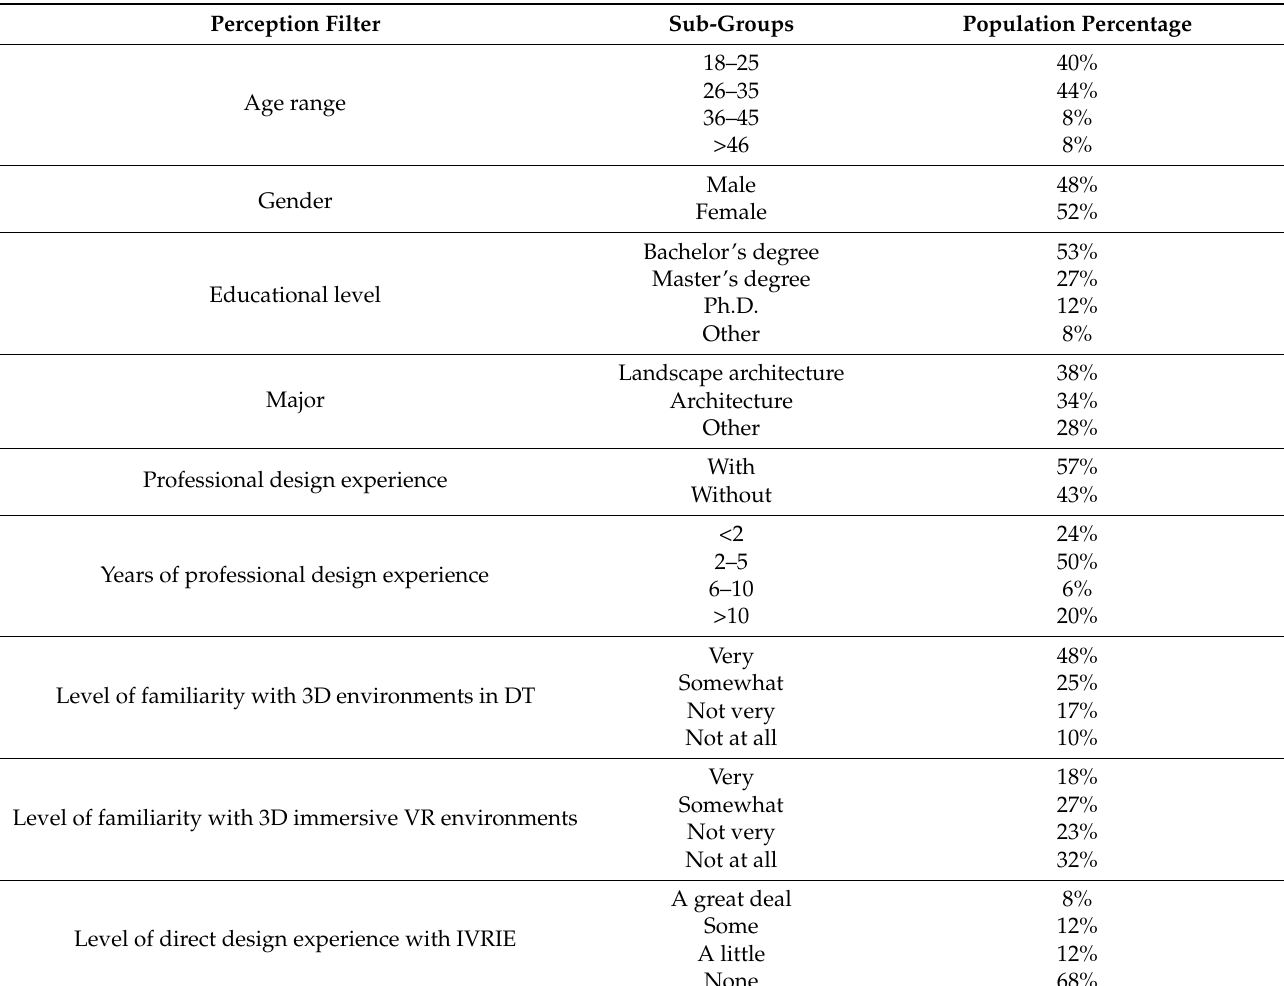
Table 1. Sample demographics.